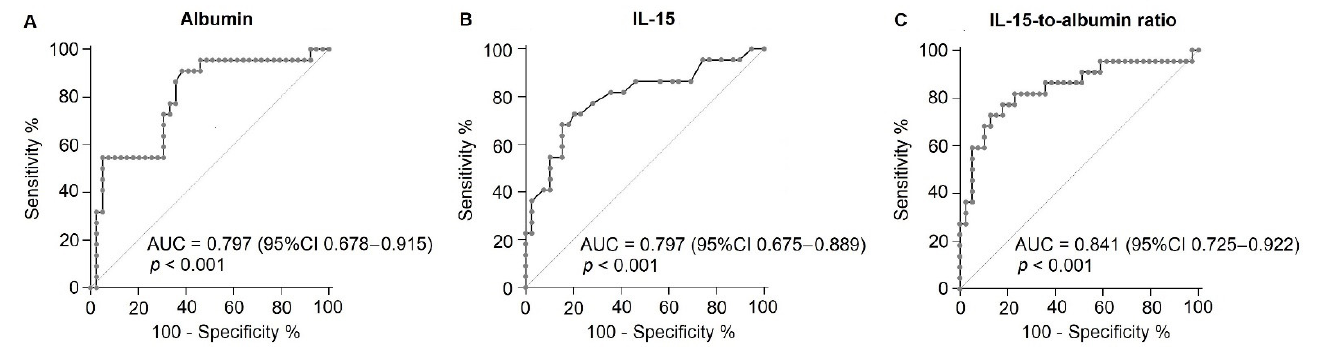
Figure 3. The area under the receiver operating characteristic curves for albumin, IL-15, and the IL-15-to-albumin ratio. ( A ) AUROC for albumin. ( B ) AUROC for IL-15. ( C ) AUROC for the IL-15-to-albumin ratio. We considered a p value < 0.05 as significant. AUROC, area under the receiver operating characteristic curves; AUC, area under the curve; CI, confi- dence